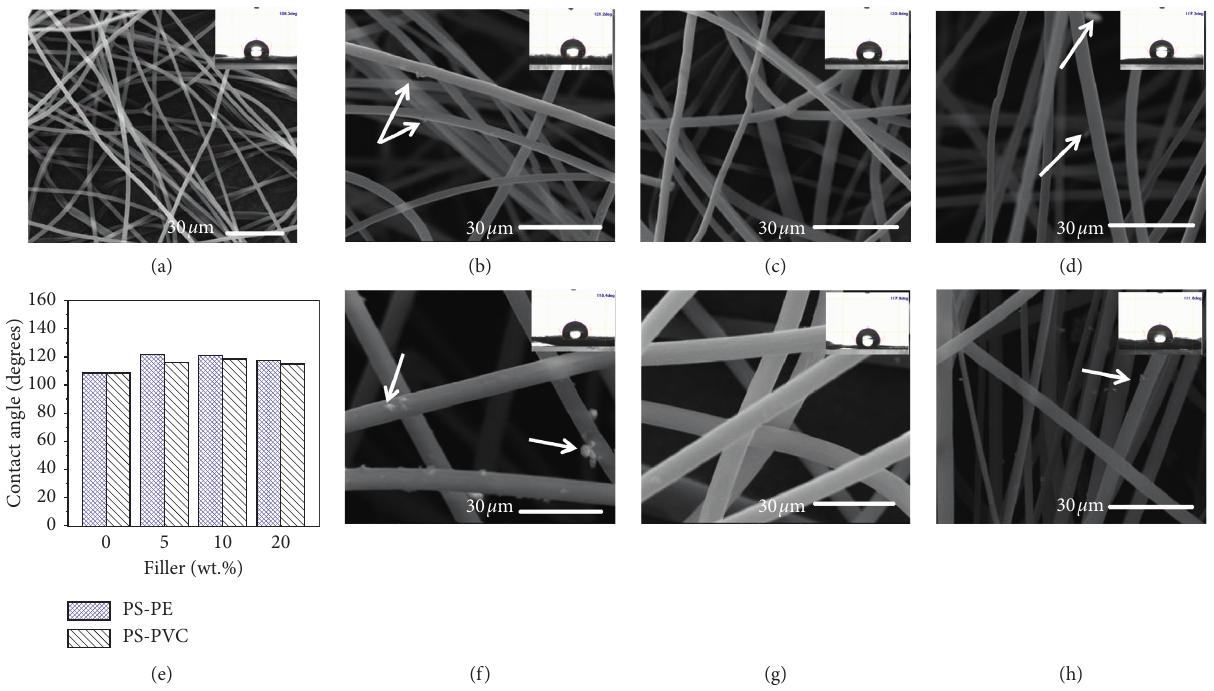
Figure 2: Scanning electron micrographs of (a) pure PS, (b–d) PS-PE, and (f–h) PS-PVC fibrous sorbents containing 5wt.% (b and f), 10wt.% (c and g), and 20wt.% (d and h) of each of the additives. (e) Variation of the contact angle with fibers’ composition.